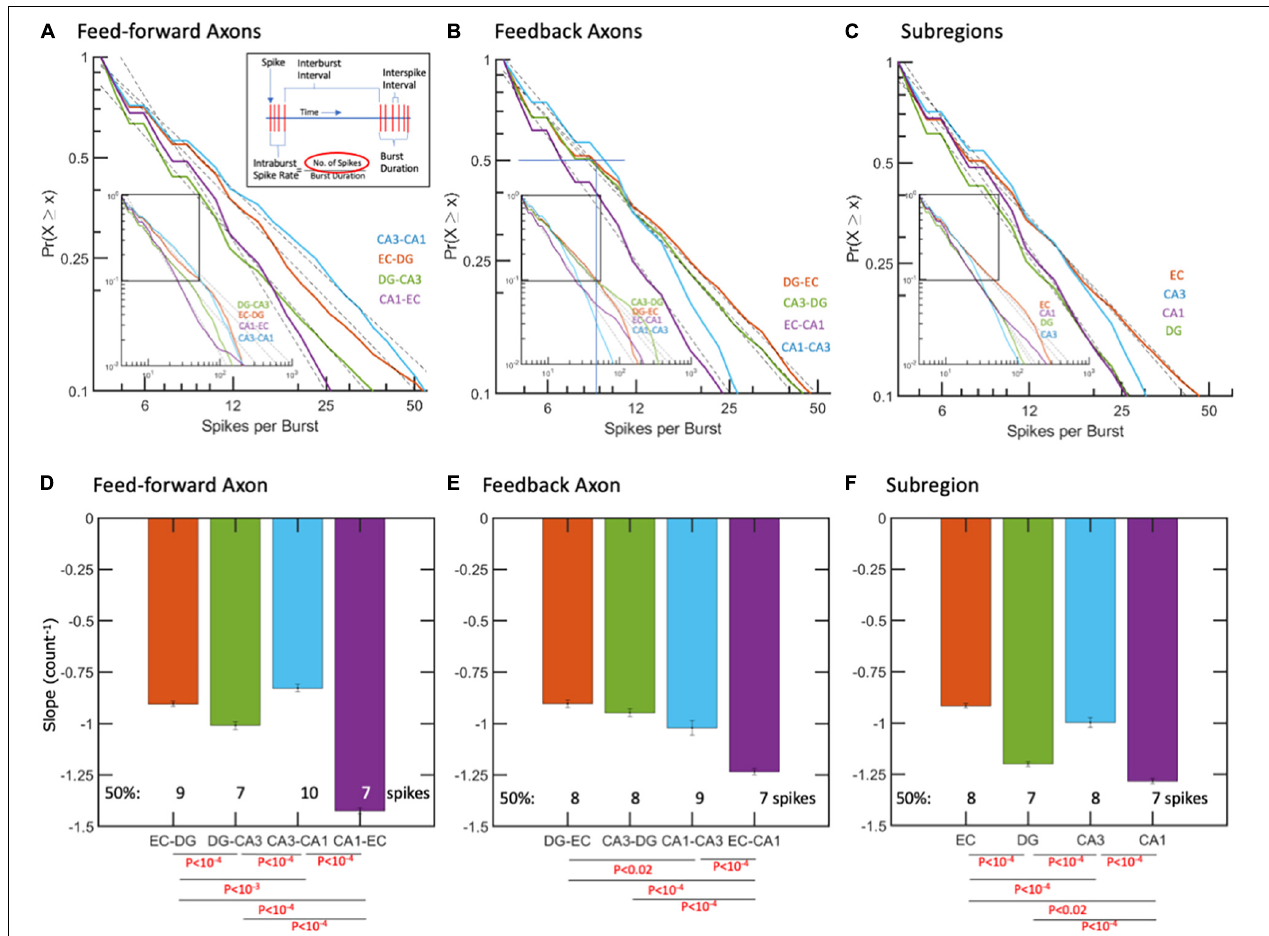
FIGURE 4 | Spikes per burst follow log-log distributions. (A,D) Feed-forward axons in CA1-EC have the steepest negative slope with least spikes/burst. (B,E) Feedback axonal spikes per burst with steepest slope and least spikes per burst in EC-CA1 axons. (C,F) Subregional ISIs are shortest (fastest) in the CA1 subregion. R 2 > 0.99 for all fits. The error bars represent the 95% confidence interval obtained by ANCOVA. Only the fraction of data between cumulative probability of 1 to 0.1 was used for fitting the linear model. P -values calculated by ANCOVA followed by Tukey